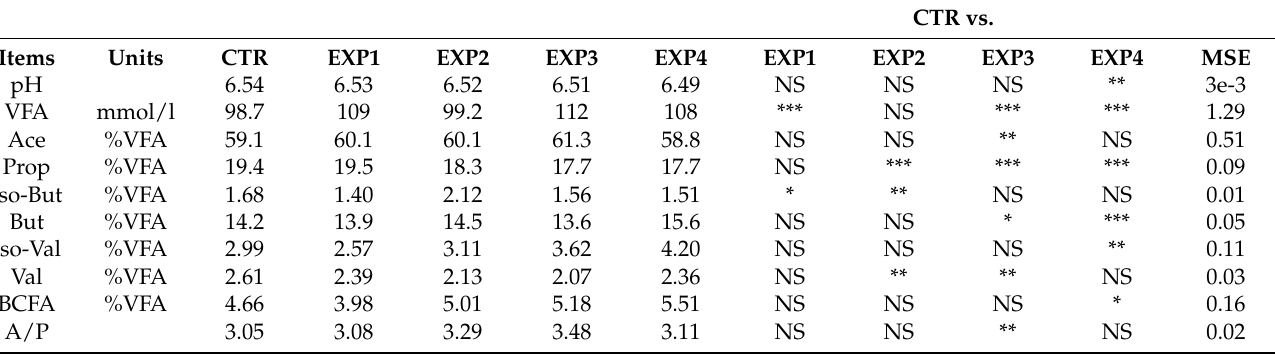
Table 6. In vitro fermentation end-products: control vs. experimental diets with bovine inoculum .